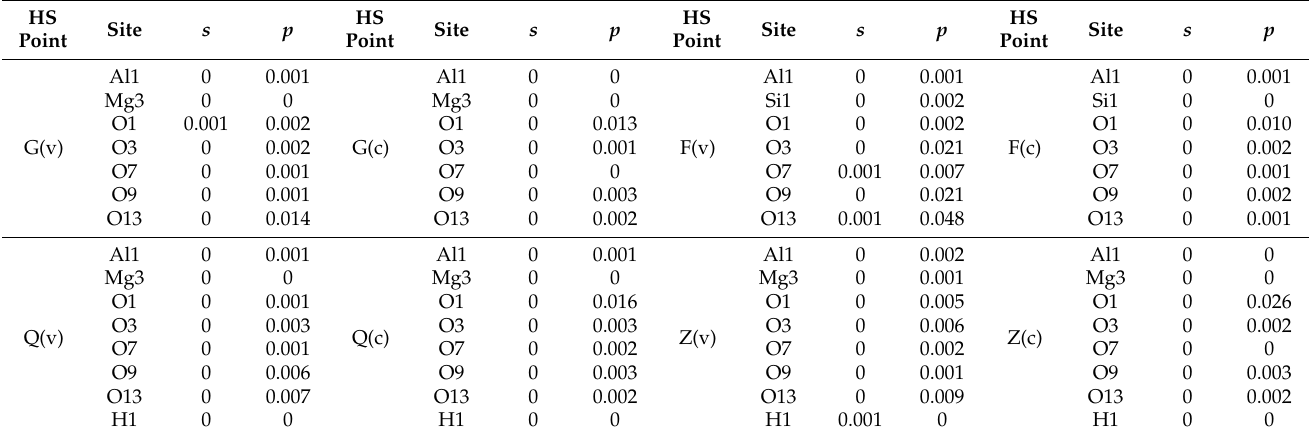
Table 4. Calculated orbital-decomposed site (atom)-projected electron charges inside the muffin-tin spheres of the Mg-MMT at the high-symmetry (HS) BZ points G, F, Q, and Z.